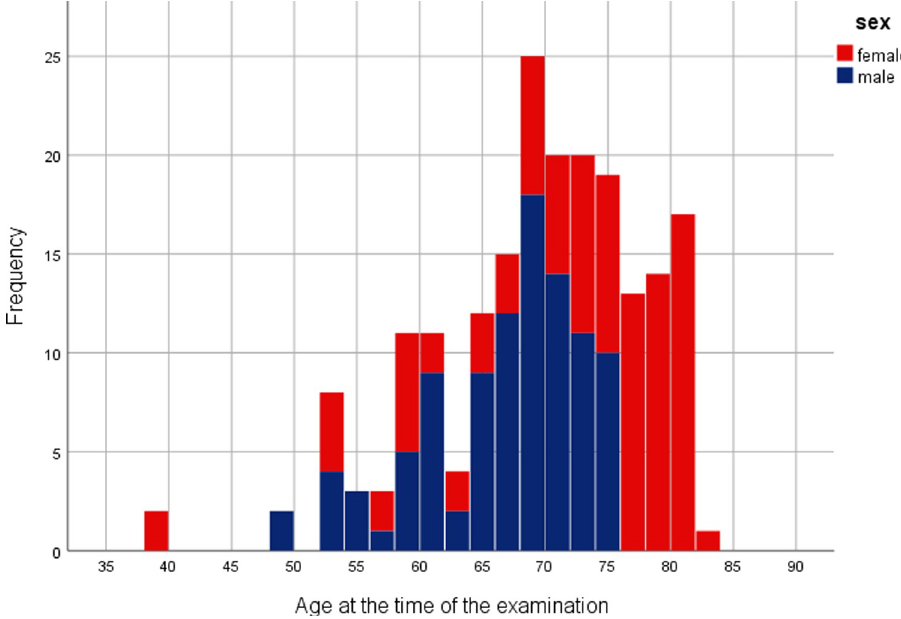
Fig 3. Age distribution. Age distribution of the study population at the time of the examination considering gender. Female patients are displayed in red, male patients in blue.